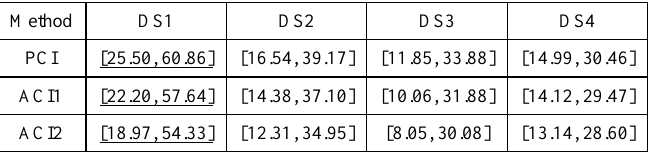
Table 3. The estimation results of model parameter 𝛼 with